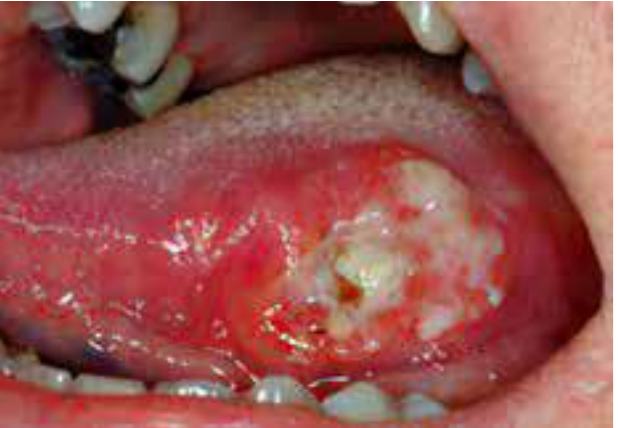
Figure 2. Oral squamous cell carcinoma on human tongue. Reprinted with permission from Ref. [71]. 2017, Dental